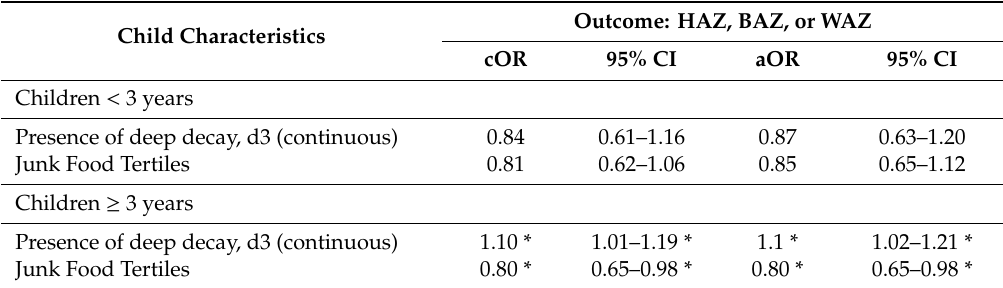
Table 5. Association of Undernutrition with Deep Decay and Junk Food Consumption 1